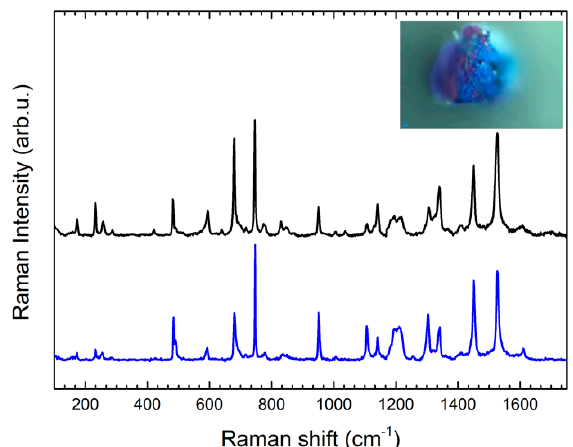
Figure 6. SERS spectrum (blue line) of sample collected with GT-SERS of blue pigments, 1 area, compared with Raman spectrum obtained with the same instrument of PB15:1 reference (black line).